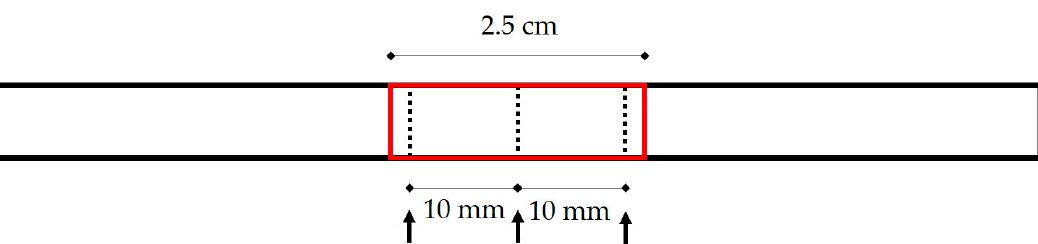
length tendon. The central mid-substance encircled in the red frame was designated as the gauge length for mechanical testing. The dashed lines pointed by black arrows delineate where the width and thickness measurements were taken.